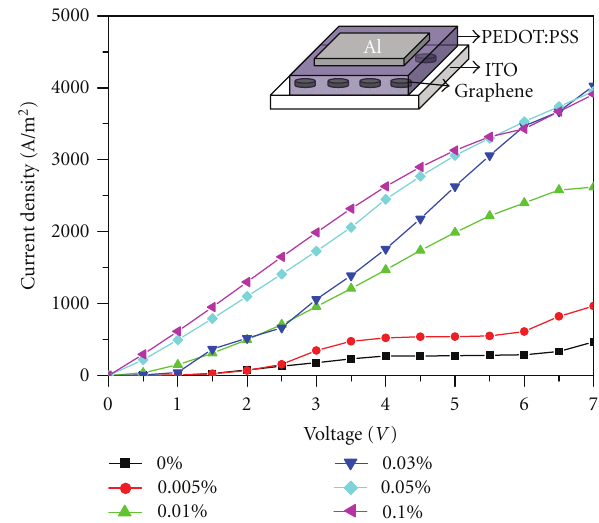
Figure 3: The J-V characteristics of hole-only device at various graphene concentrations. The inset shows the device